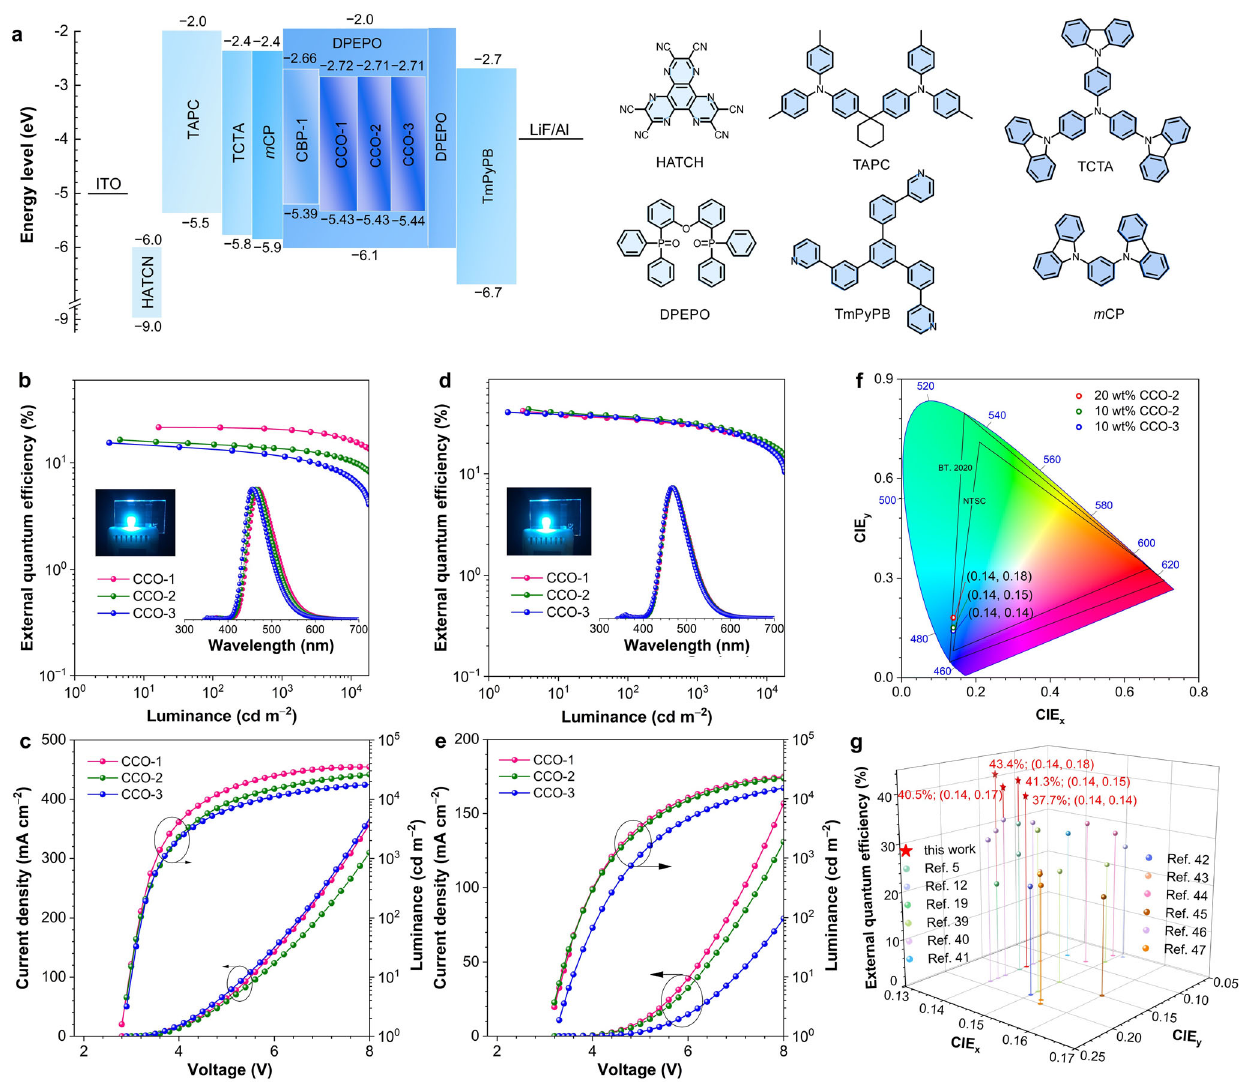
Fig. 4 | EL performance of nondoped and doped OLEDs. a Device architecture, energy diagram and functional layers of the OLEDs based on the new materials. Plots of b, d external quantum ef fi ciency ‒ luminance and c, e luminance ‒ voltage ‒ currentdensityofthenondopedanddopedOLEDs.Insetsinplanes b,d :ELspectra